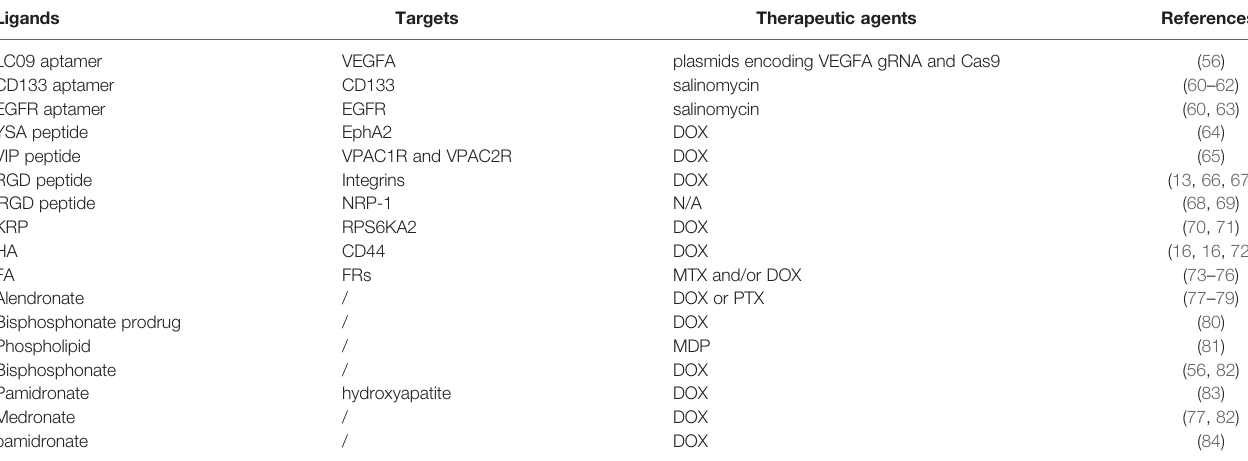
TABLE 3 | Targeted delivery based on aptamers, peptides, saccharide, vitamin or bisphosphonates as ligands.